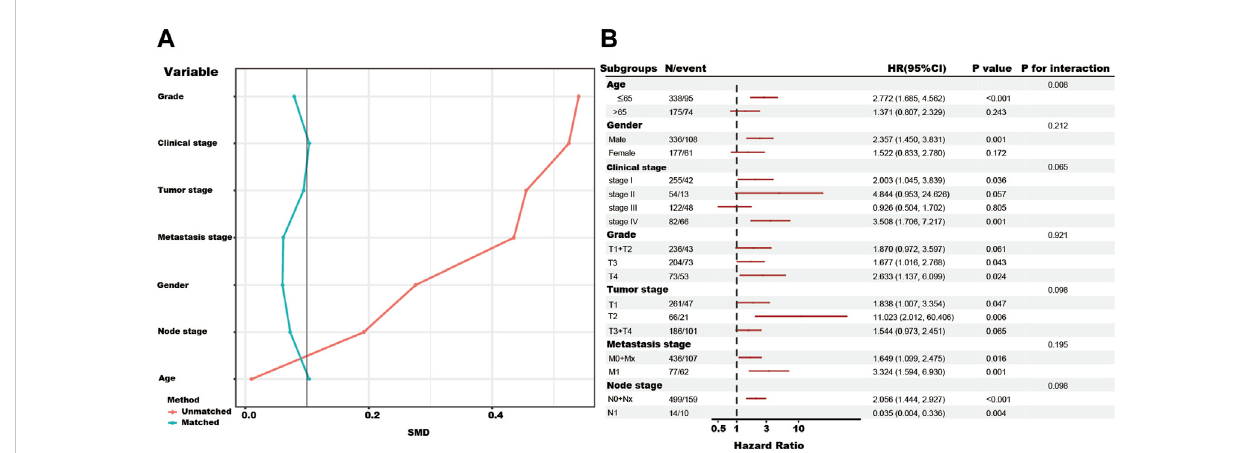
FIGURE 3 The propensity-matched analysis (PSM), subgroup analysis, and interaction testof SUMOylation risk group in the total TCGA cohort. (A) The red line showedtheSMDvalueoftheoriginaltotalTCGAcohort.ThegreenlinesshowedtheSMDvalueofeachvariableafter theadjustmentofthePSManalysis. (B) The forest fi gure showed the result of the subgroup analysis and interaction test, and low-risk group as the